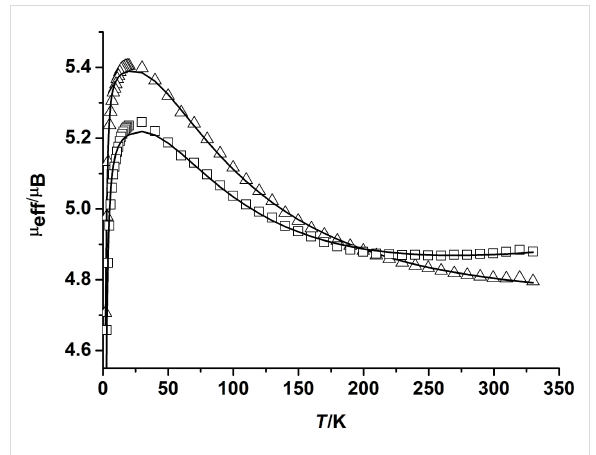
Figure 4: Temperature dependence of the effective magnetic moment μ eff (per dinuclear complex) for 7 (open triangles) and 8 (open squares). The solid lines represent the best fits to Equation